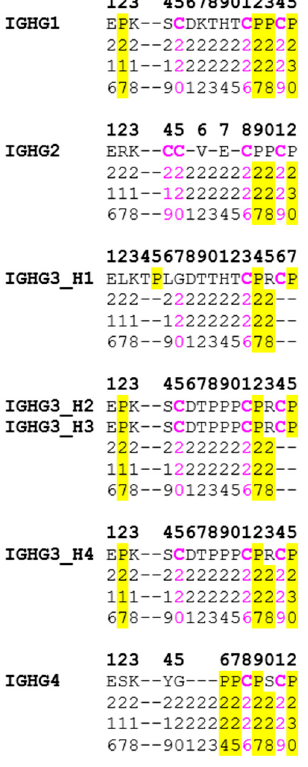
Figure 6. Correspondence between the Homo sapiens IGHG1, IGHG2, IGHG3 (4 exons) and IGHG4 IMGT numbering with the IGHG1 Eu positions. The top line indicates the IMGT numbering for the IGHG1, IGHG2 and IGHG4 hinges and for the four exons (H1 to H4) of the IGHG3 hinge. The Eu numbers are read vertically (on three lines top to down) at each position below the amino acid sequence. Dashes indicate the positions that are absent in the Eu numbering. Cysteines (C) and prolines (P) with Eu positions are highlighted in pink and yellow, respectively. (Drawn by Marie-Paule Lefranc and G é rard Lefranc, LIGM, Founders and Authors of IMGT ® , the international ImMunoGeneTics information system ® , https://www.imgt.org, Copyright 2022).